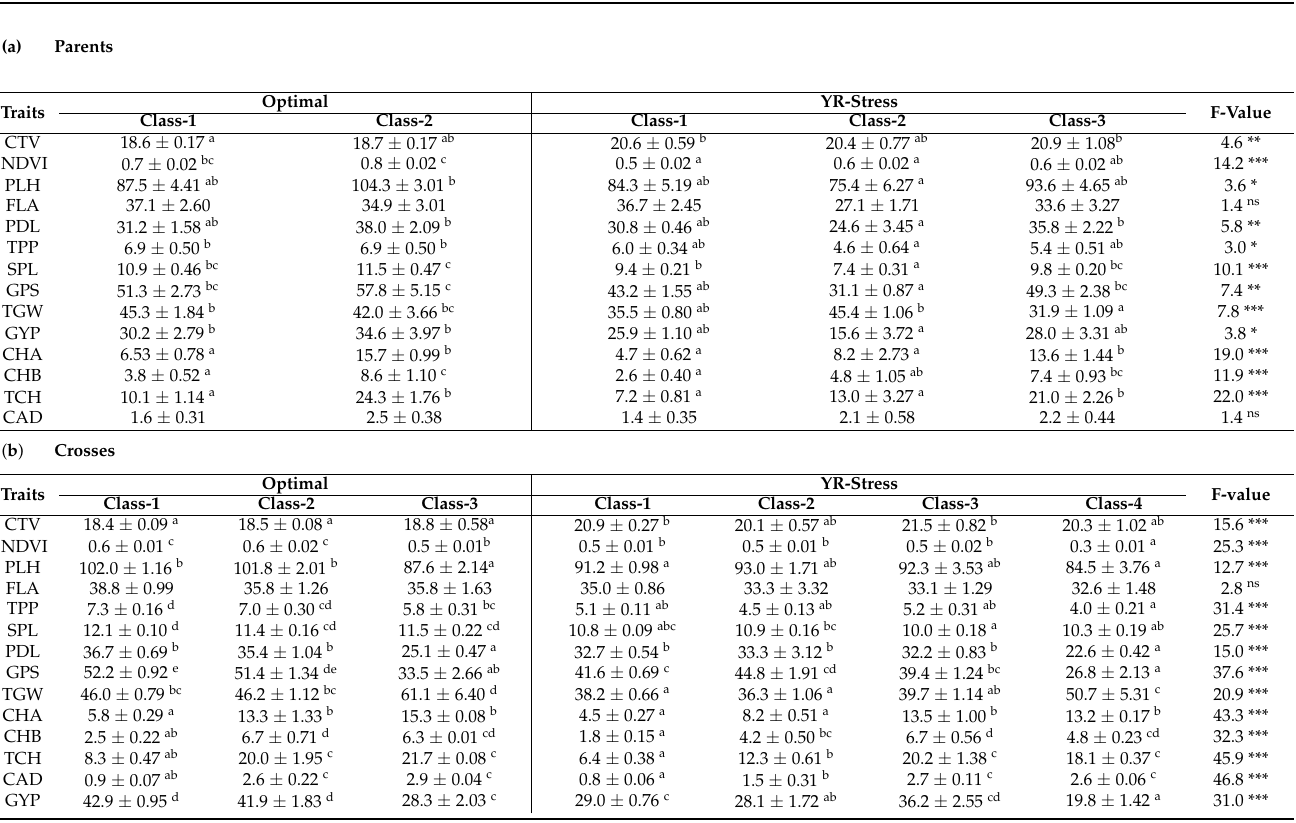
Table 7. Mean values of different parameters in (a) parents and (b) crosses based on distance classes in disease free and YR stress